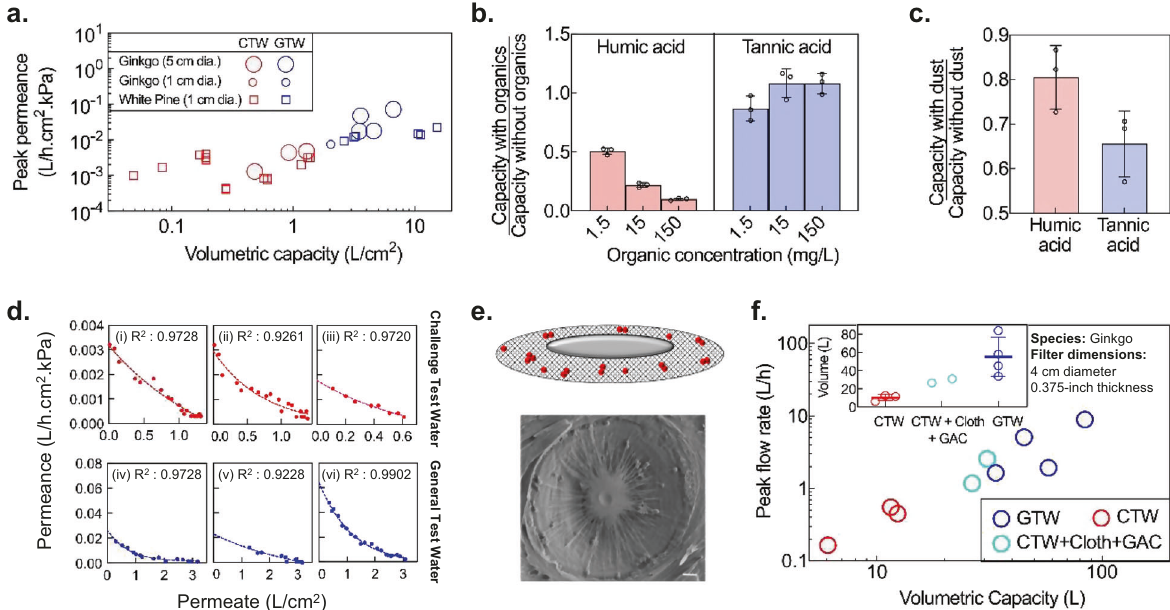
Fig. 4 Effect of water quality on fi lter performance. a Peak permeance and volumetric capacity normalized by area for general test water (GTW) and challenge test water (CTW). Each data point represents a different fi lter (one measurement per fi lter) with 0.375-inch thickness operated under 1-m gravity head. b , c Filter capacity is most susceptible to humic acid, followed by dust and tannic acid (1-cm diameter, 0.375-inch-thick Eastern white pine fi lters operated under 1-m gravity head; mean ± s.d.; n = 3 different fi lters) (see “ Methods ” for experiment details). In b , either humic acid or tannic acid is added to water. In c , water contains 70 mg/L dust or no dust in either 15 mg/L humic acid or tannic acid. d Decrease in fi lter permeance with CTW (red) and GTW (blue) is well- fi tted by the intermediate fouling model (dashed lines). Each graph represents measurements on a single fi lter under 1-m gravitational head. (i) – (v): Eastern white pine, 1-cm diameter, 0.375-inch thickness. (vi): Ginkgo, 4-cm diameter, 0.375-inch thickness. e Schematic illustrating the deposition of foulant particles (red) on the pit membrane in the intermediate fouling model, which is consistent with foulant deposition observed by SEM in a partially fouled ginkgo fi lter. Scale bar, 1 μ m. f Pre-treatment with cloth and granular activated carbon (GAC) improves the peak fl ow rates and volumetric capacity of ginkgo fi lters with GTW and CTW at 1-m gravity head. Inset shows mean ± s.d. of the volumetric capacity; n = 3, 2, and 4 different fi lters with CTW, CTW + Cloth + GAC, and GTW,